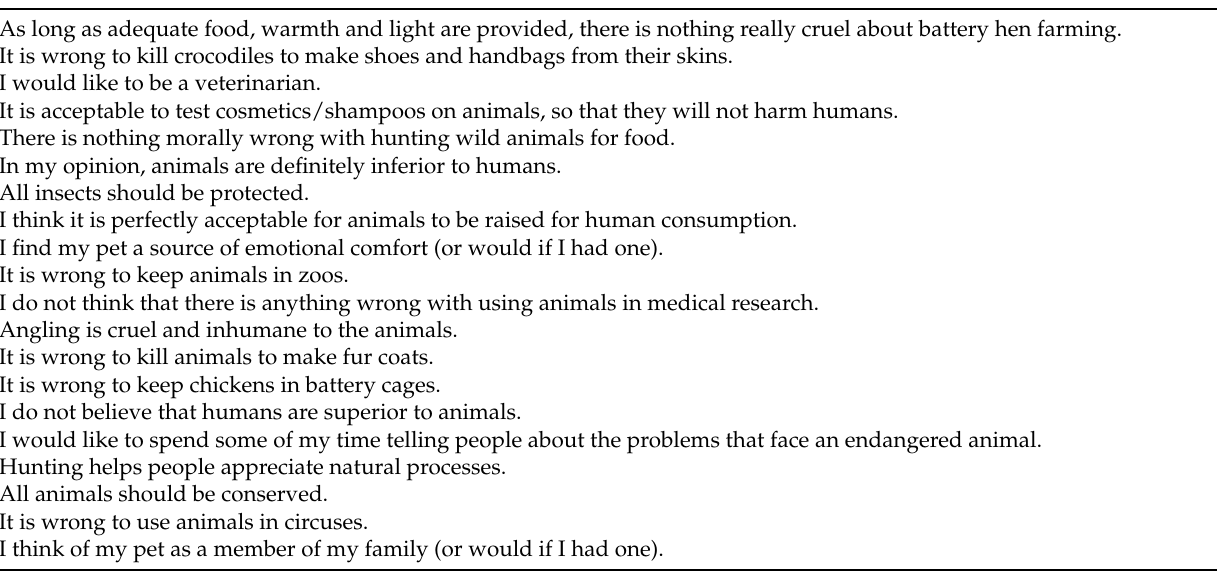
Table A1. Items of the Composite Respect for Animals Scale (short